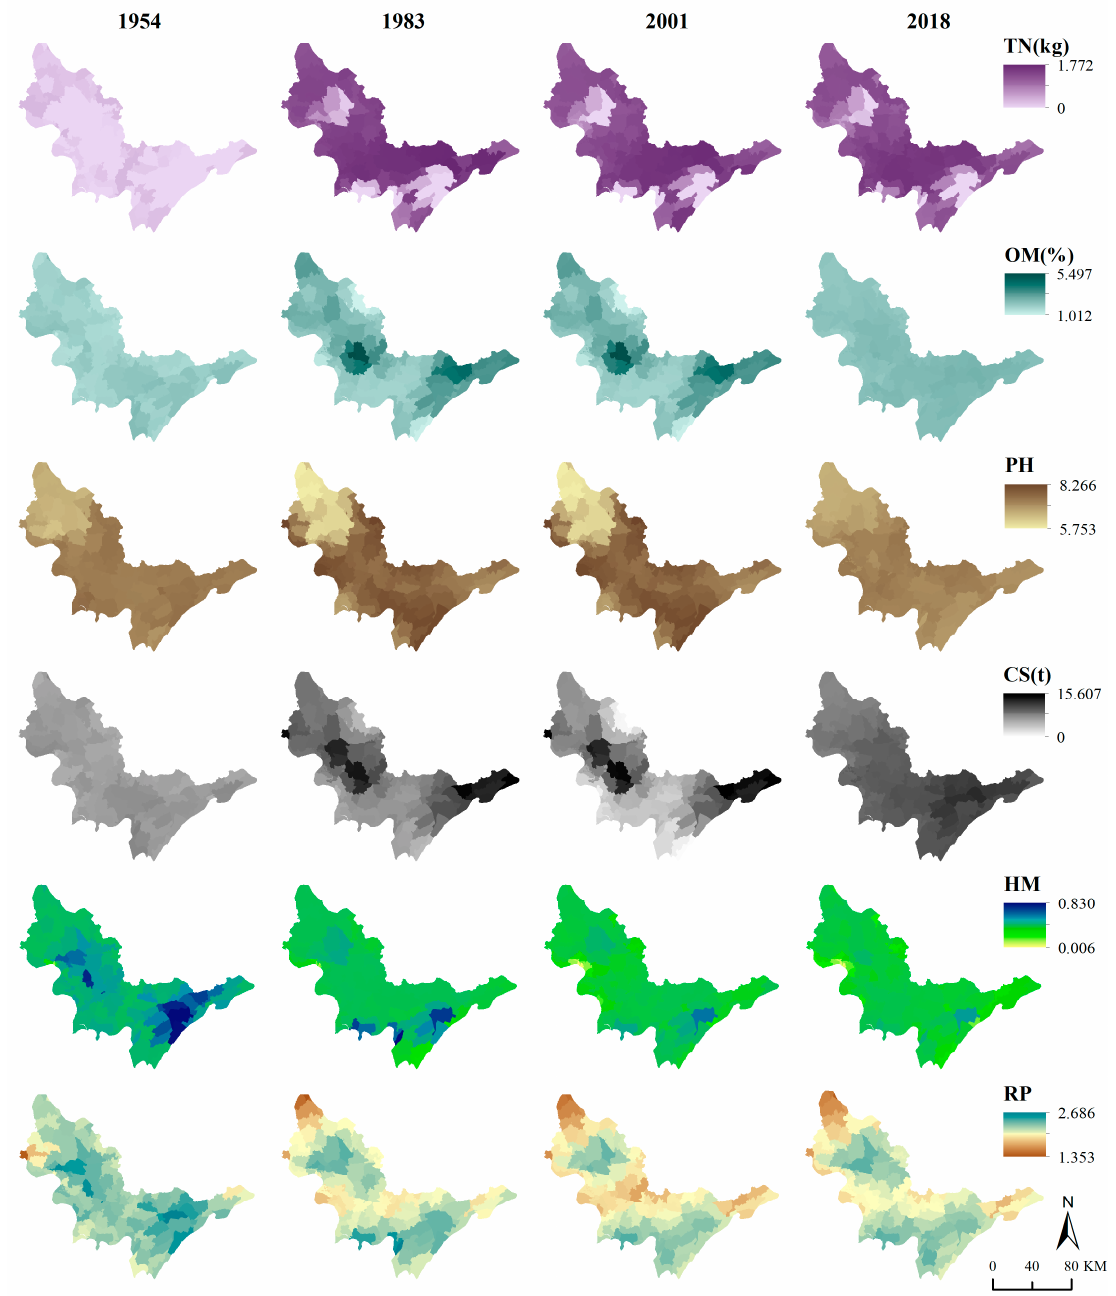
Figure 3. The spatiotemporal pattern of individual ES in 1954, 1983, 2001, 2018. RE: rice; CN: cotton; OC: oil crop; FP: freshwater products; WY: water yield; RO: runoff; HQ: habitat quality; TP: total phosphorus export; TN: total nitrogen export; CS: carbon storage; OM: soil organic matter; pH: pH value; RP: recreation potential. Low to high indicates the values of ES.